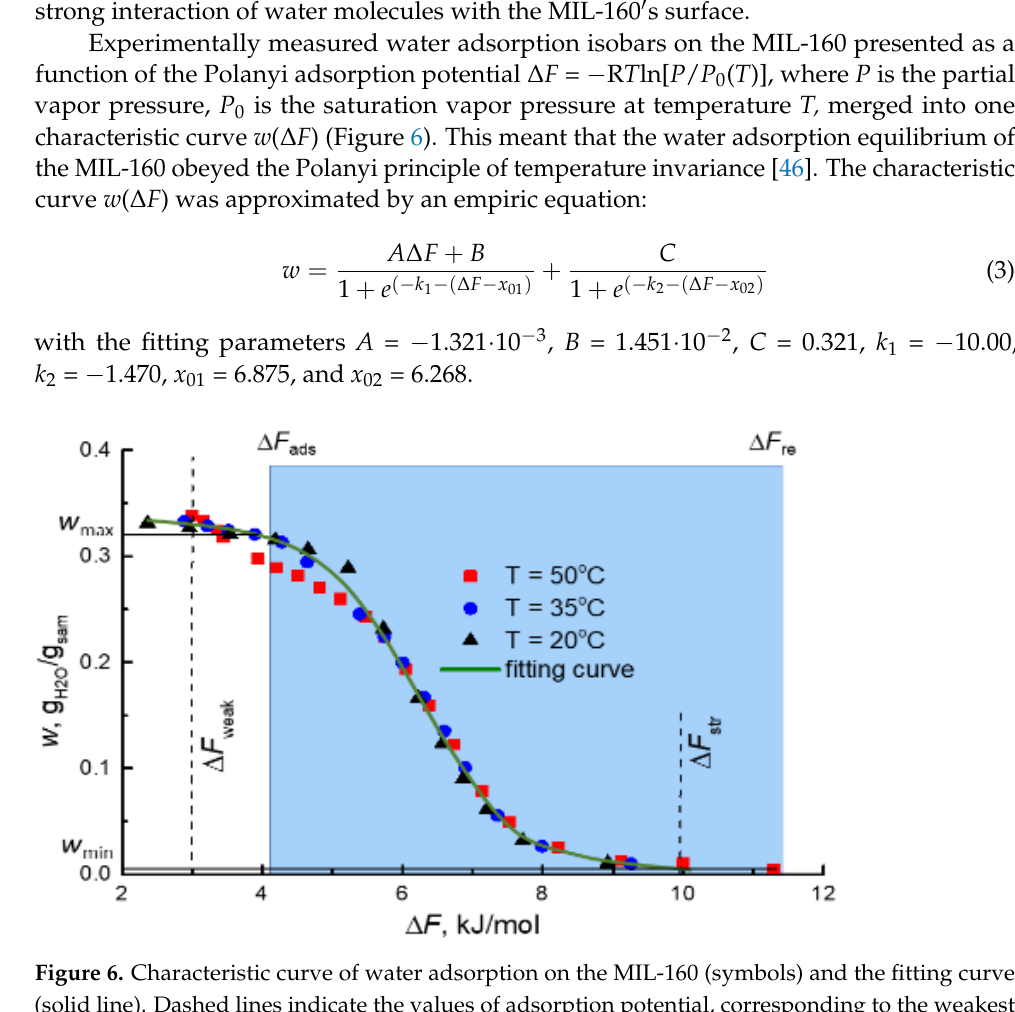
Figure 6. Characteristic curve of water adsorption on the MIL-160 (symbols) and the fitting curve (solid line). Dashed lines indicate the values of adsorption potential, corresponding to the weakest ( ∆ F weak ) and strongest ( ∆ F str ) adsorption sites. The blue area shows the ∆ F range for the boundary conditions of the AWHA cycle in Riyadh-Old during the dry season